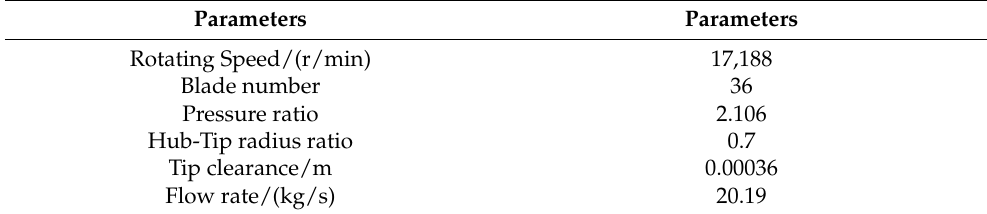
Table 1. The design parameters of rotor37.